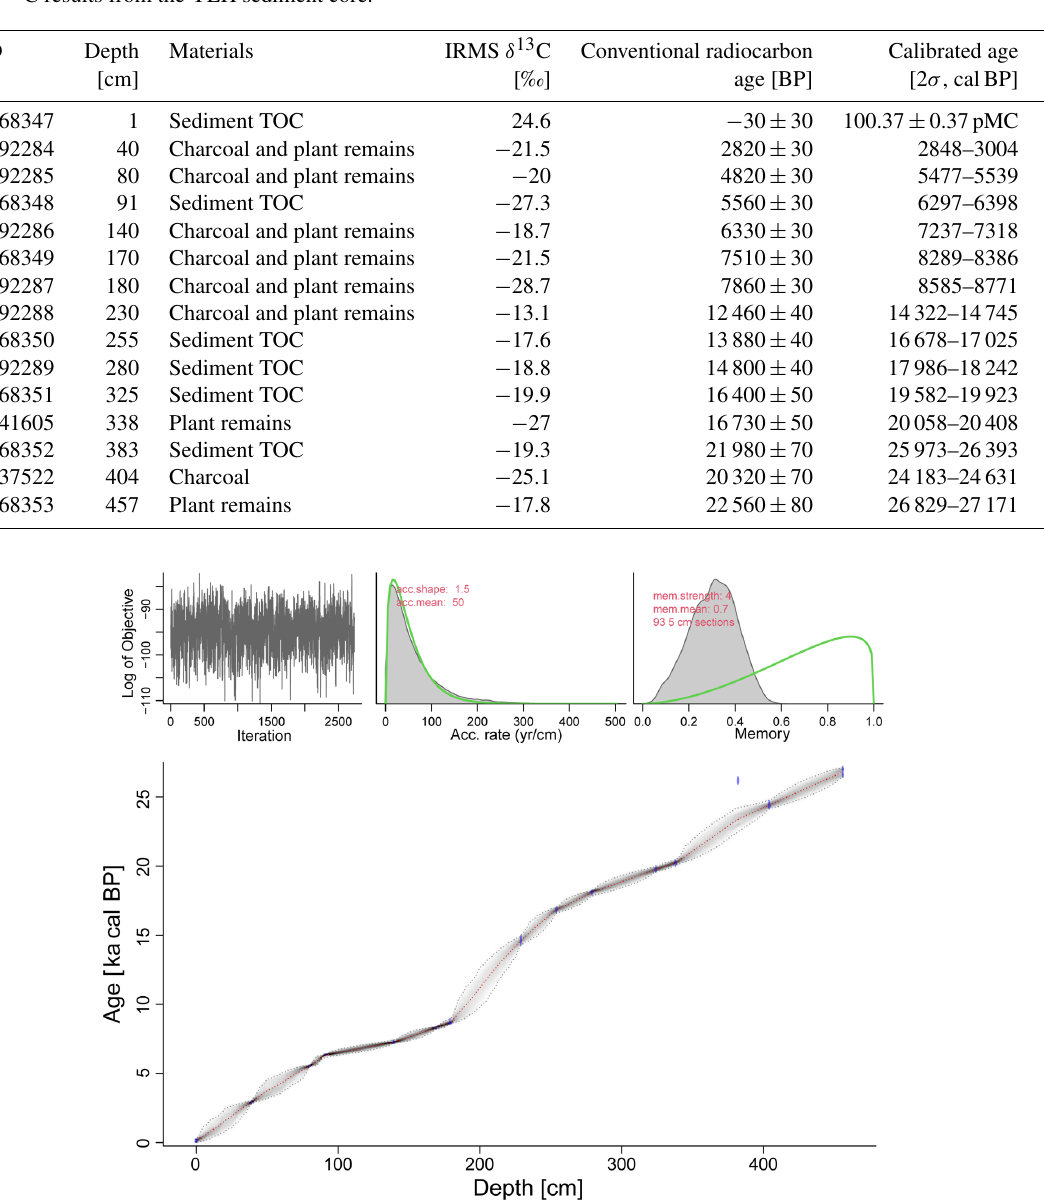
Table 1. AMS 14 C results from the YLH sediment core.